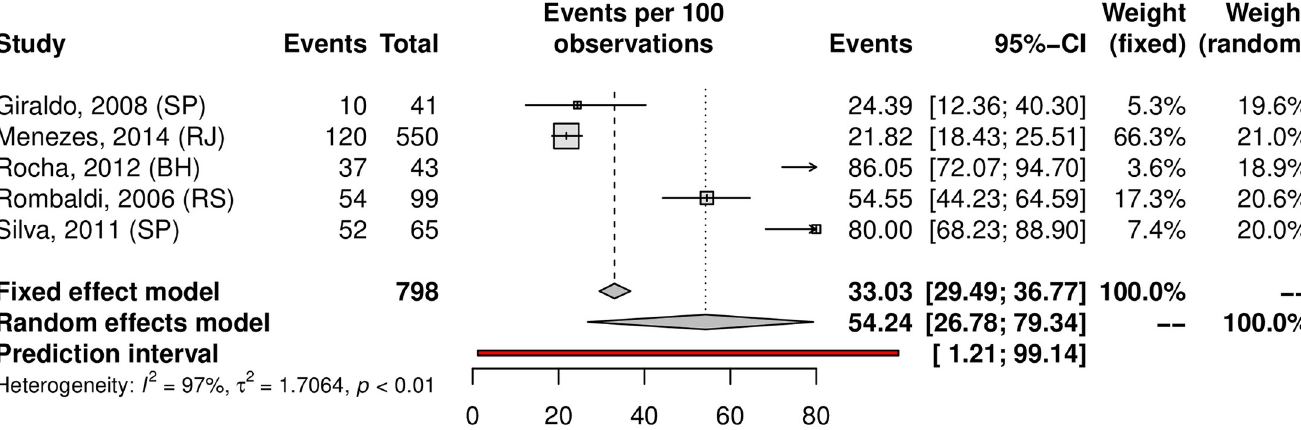
Fig 15. Prevalence of penile HPV infection in high-risk populations. Forest plot of a metanalysis of studies reporting prevalence of penile infection by HPV in high- risk populations in Brazil.